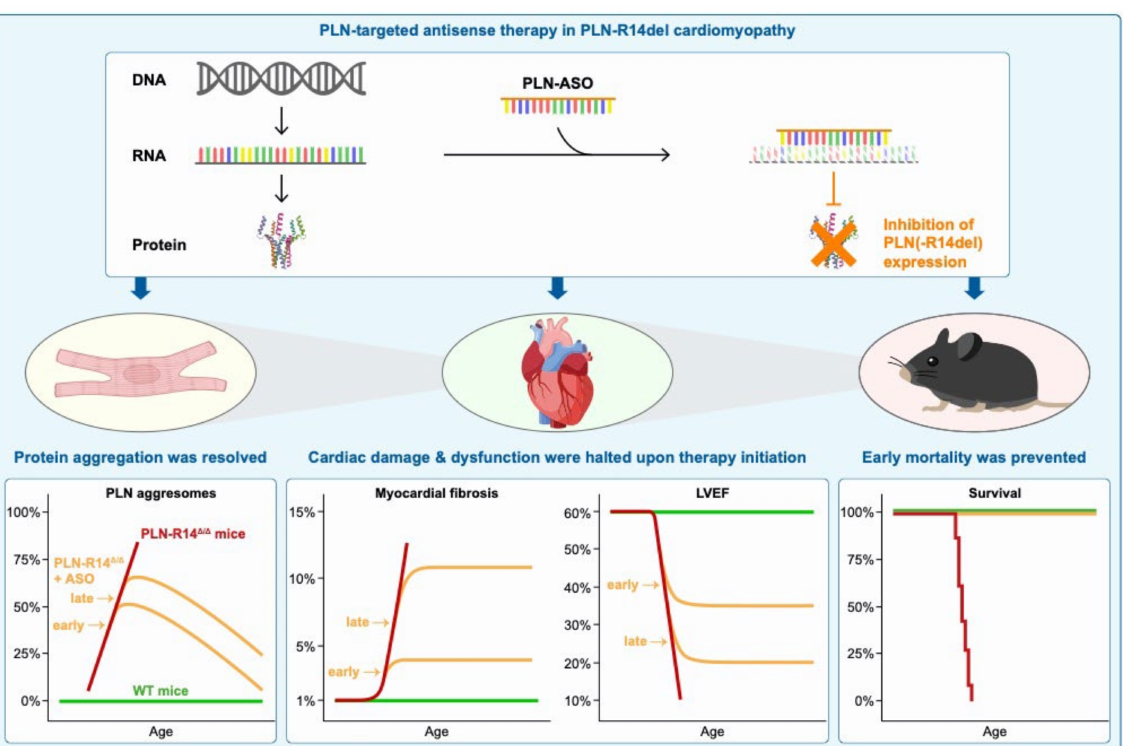
Figure 6. Visual summary of the main findings of this study. PLN-R14 ∆ / ∆ mice exhibited cardiomy- opathy in an accelerated manner with a similar phenotype as human patients, including PLN protein aggregation, severe myocardial fibrosis, and HF. Upon PLN-ASO therapy, Pln mRNA was degraded, resulting in inhibition of PLN protein synthesis. Even when PLN-ASO was administered at an advanced stage of cardio-myopathy, PLN aggregates were cleared, and further progression of cardiac remodeling and dysfunction was halted quickly after treatment initiation. Ultimately, survival of PLN-R14 ∆ / ∆ mice was prolonged by at least three-fold, indicating that PLN-ASO therapy has great beneficial effects in PLN-R14del cardiomyopathy at severe disease